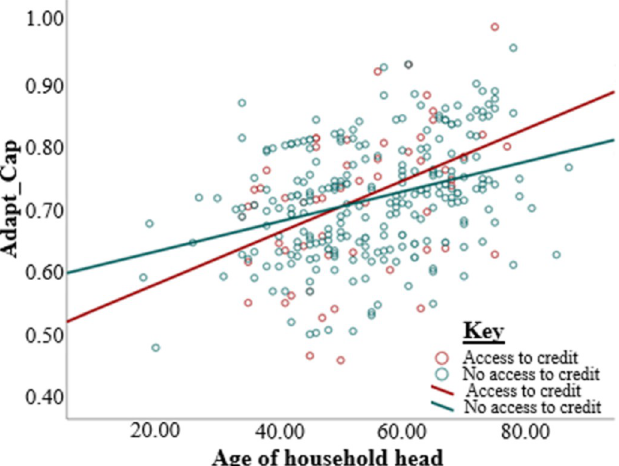
Fig 1. The interaction between the age of the household head and access to credit (all other factors controlled).